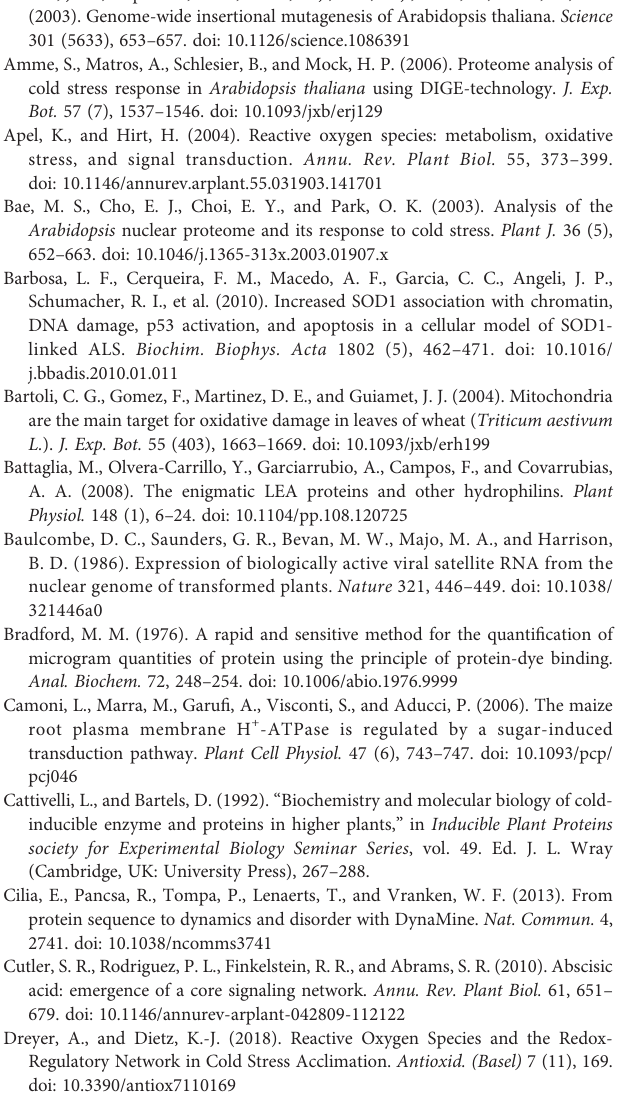
FIGURE S1 | SDS-PAGE and Western blot analysis on STRP. To test the ability of the anti-STRP polyclonal antibody to recognize STRP, 1 µg of puri fi ed recombinant protein and 15 m g of plant whole cell extract (W.C.E.) were separated by 12% SDS- PAGE, transferred on PVDF membrane and incubated with the anti-STRP antibodies. CBB, Coomassie Brilliant Blue; WB, western blot. FIGURE S2 | The strp mutant is homozygous for the T-DNA insertion, leading to loss of STRP expression. A: left panel, schematic model of the T-DNA insertion in the STRP promoter; right, genomic three-oligonucleotides PCR for the identi fi cation of homozygous mutant lines. Genotype analysis of the strp mutant was carried out on two different plant generations, named T2 and T3, with a genomic PCR using three primers: LP primer 5 ’ -TACACTCACTCGTCACTCCCC- 3 ’ , RP primer 5 ’ -TAAATGTCTTTTTCGGCAACG-3 ’ and LBb1.3 primer 5 ’ - ATTTTGCCGATTTCGGAAC-3 ’ . The genomic DNA extraction was performed with the “ DNeasy ® Plant Mini Kit ” (QIAGEN) according to manufacturer ’ s instructions. The reaction with LB+RP, complementary to the STRP promoter, and with BP+RP, complementary to the T-DNA insertion and the STRP promoter,